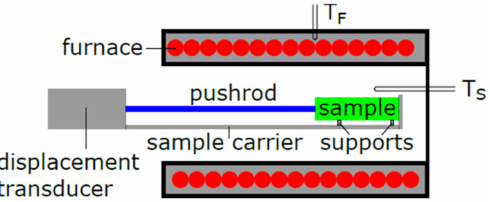
Figure 7. Sketch of a horizontal push rod dilatometer.